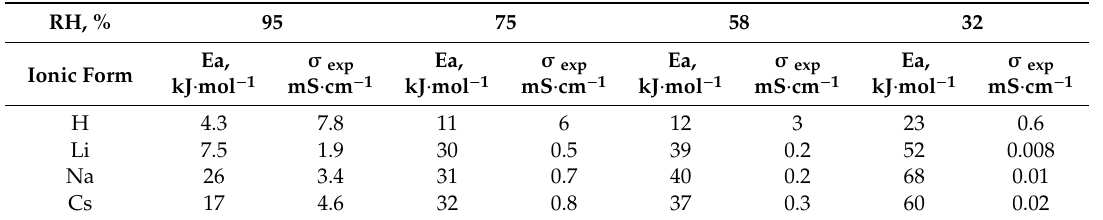
Figure 7. Temperature dependences of experimental σ exp (1–4) and calculated σ calc (2 (cid:48) –4 (cid:48) ) ionic conductivities in H + (1), Li + (2) and (2‘), Na + (3) and (3 (cid:48) ), and Cs + (4) and (4 (cid:48) ) ionic forms of MSC membrane at RH = 95%. Table 3. Experimental values of ionic conductivity at 25 ◦ C and conductivity activation energies of H + , Li + , Na + , and Cs + cations in MSC membrane with di ff erent humidity. IEC = 2.5 mg–eq /